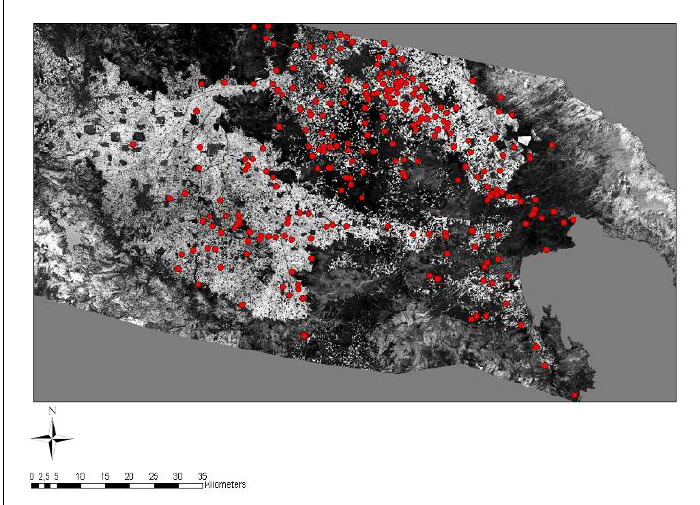
Figure 14. Application of NDVI to Landsat image. The Neolithic settlements appear as red